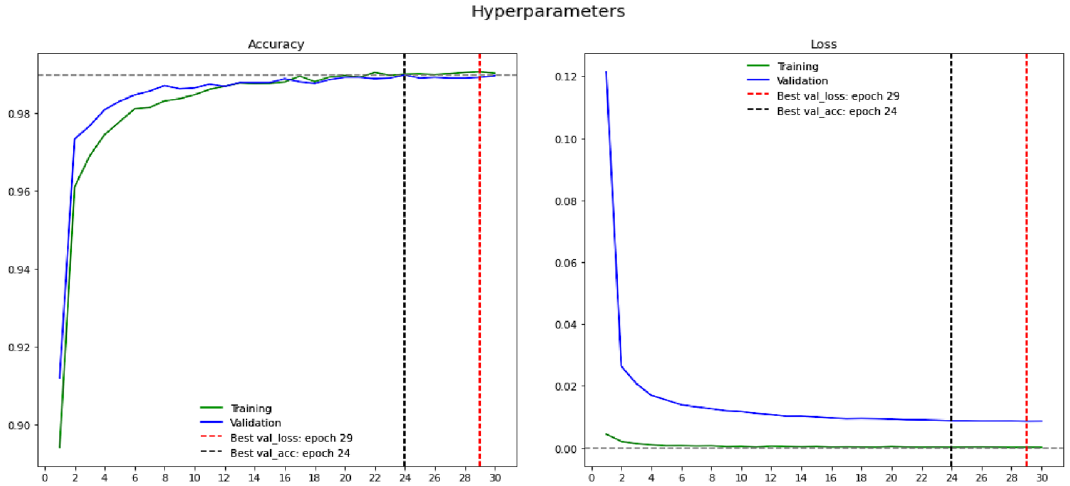
Figure 8. Graphs presenting the hyperparameters of the proposed